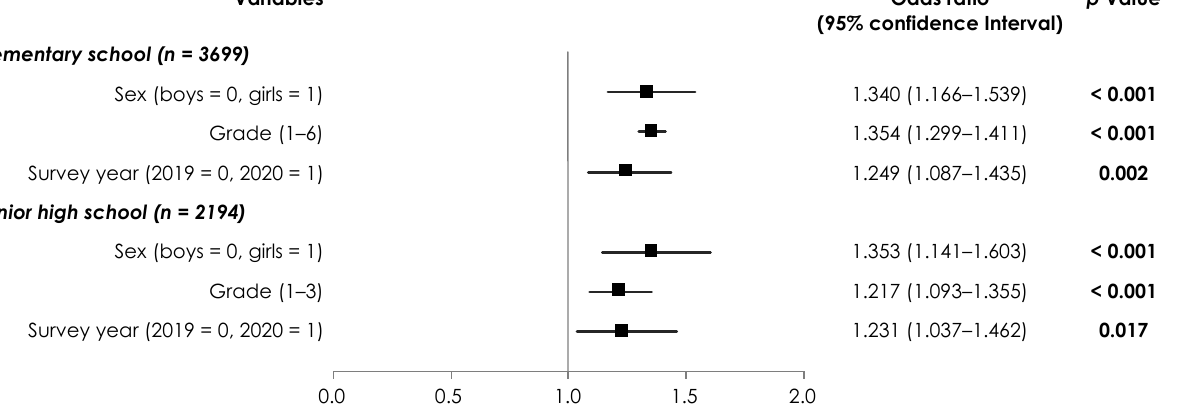
Figure 2. Relationship between eyesight in 2019 and the changes in eyesight from 2019 to 2020. The dependent variable was the change in eyesight from 2019 to 2020 (0 = no change or positive change, 1 = negative change), and the independent variable was the